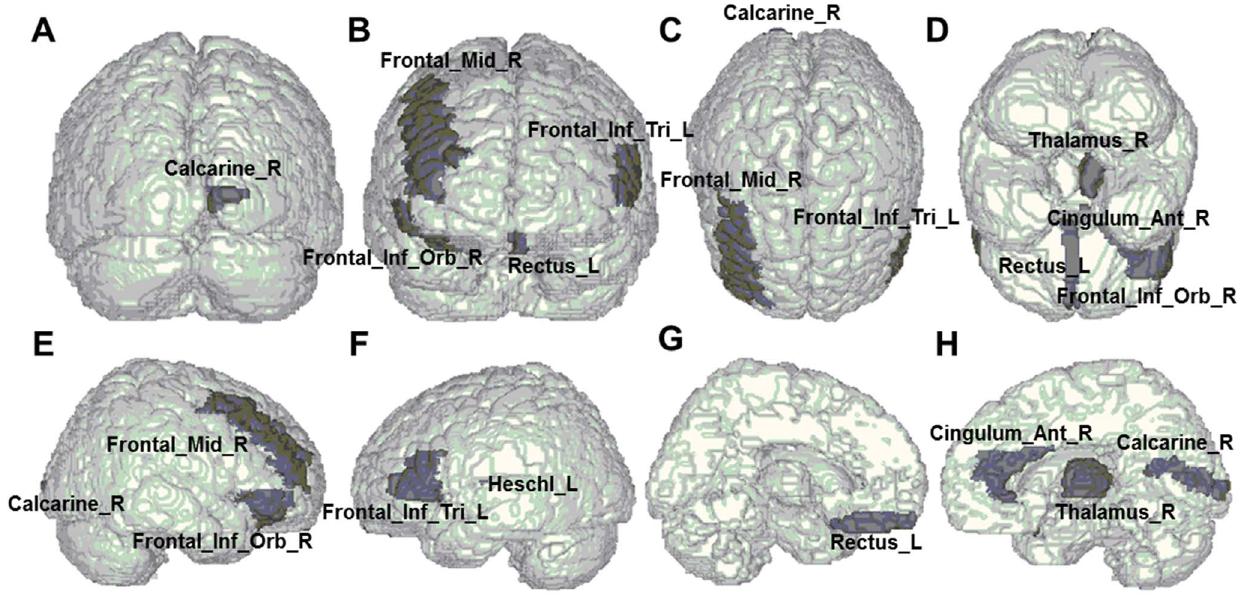
Figure 1. Anatomical regions exhibiting significant differences of cortical shape complexity between non-remitting depressed patients and healthy controls. The curvedness values significantly differed between non-remitting patients and healthy controls in the the right middle frontal gyrus (Frontal_Mid_R), the orbital part of right inferior frontal gyrus (Frontal_Inf_Orb_R), the left gyrus rectus (Rectus_L), and the right calcarine fissure and surrounding cortex (Calcarine_R) in the sucal pits. Significant differences also existed in the gyral saddle parts of the right thalamus (Thalamus_R) and the left Heschl gyrus (Heschl_L) and the gyral nodes of the right anterior cingulate and paracingulate gyri (Cingulum_Ant_R). In the triangular part of left inferior frontal gyrus (Frontal_Inf_Tri_L), we also discovered significant differences in the gyral saddle and sulcal saddle areas, respectively. All areas exhibiting significant differences were shown in (A) posterior, (B) anterior, (C) superior, (D) inferior (E) right-lateral, (F) left-lateral, (G) left-medial, and (H) right-medial views.